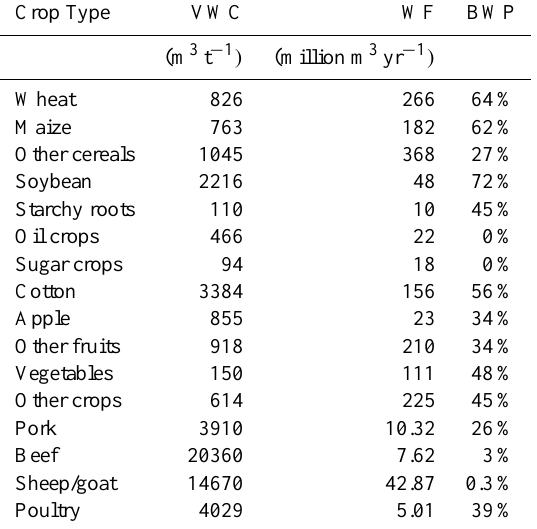
Table 2. Virtual water content (VWC), water footprint (WF) and blue water proportion (BWP) of crop and livestock production within the HRB